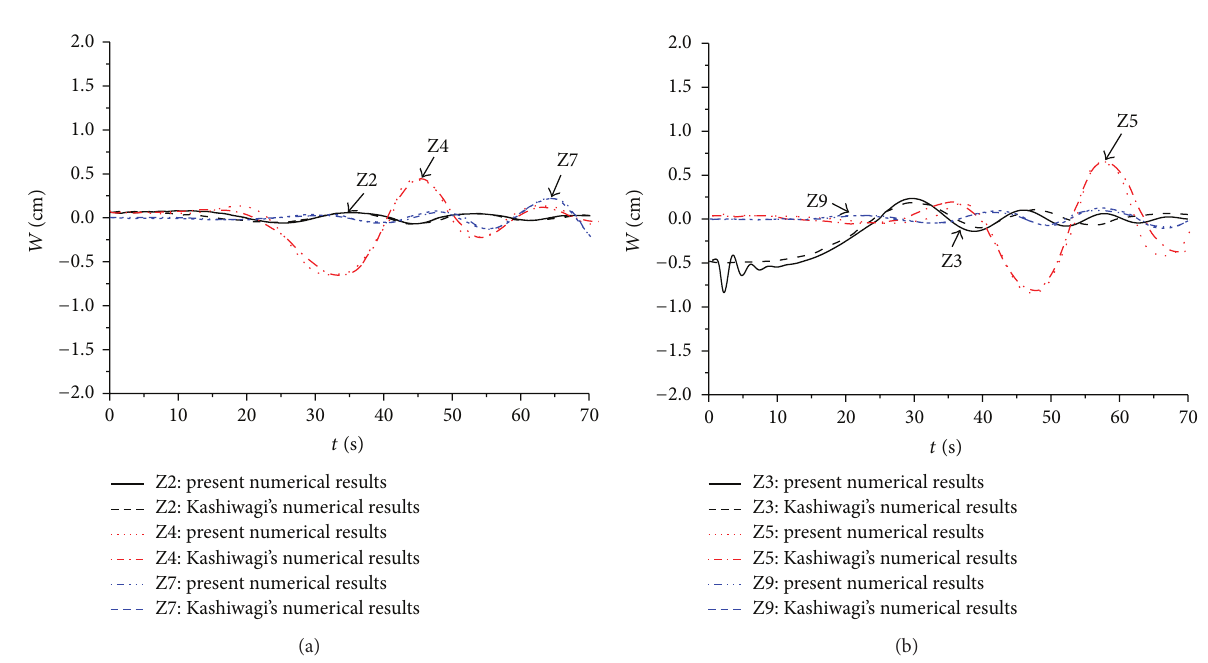
Figure 14: Time histories of the vertical displacement subjected to takeoff of